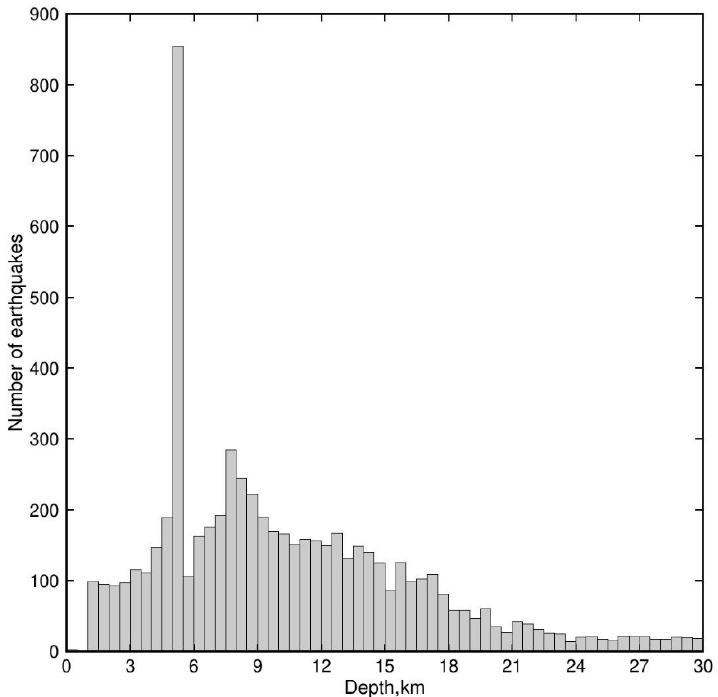
Figure 4. Number of earthquakes with depth distribution for Denizli from 2000 to 20 December 2018.